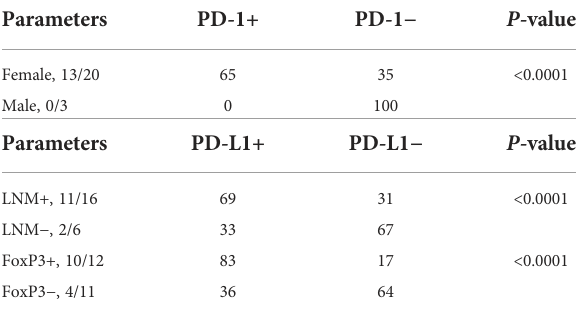
TABLE 2 Clinicopathological association of PD-1 and PD-L1 expression.